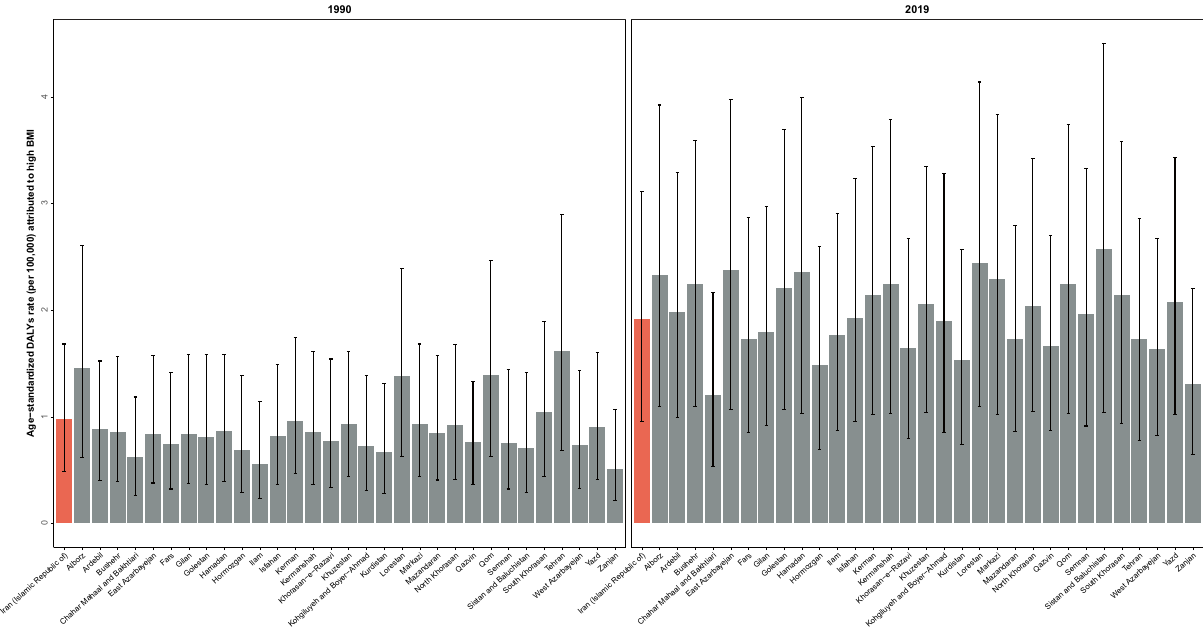
Figure 5. The thyroid cancer age-standardized DALYs attributed to high BMI in 1990 and 2019 in both sexes in provinces of ranged from 12% (− 27 to 67) to 92% (− 11 to 191). However, the ASDR decreased in four provinces from − 0.2 (− 31.9 to 42.1) in Chahar Mahaal and Bakhtiari to − 32% (− 52 to − 6) in Tehran (Supplementary Table 1 and Supplementary Fig. 1). In 1990, females had higher ASDR than males in all provinces, whereas in 2019, males had higher ASDR in five provinces. However, the significance of these differences has to be further evaluated in most of the provinces. However, in 2019, all provinces had lower female to male ratio compared to 1990. Fur- thermore, the highest and lowest female to male ratio in 1990 was 2.75 and 1.34, and in 2019, it was 2.05 and 0.80 respectively (Supplementary Table 1). Moreover, the age-standardized Mortality to Incidence Ratio (MIR) was higher in males in all of the provinces from 1990 to 2019 (Supplementary Fig. 2). Thyroid cancer DALYs. In the case of thyroid cancer DALYs among provinces of Iran, disparities were observ- able. Indeed, in 2019, it varied from 9.17 (7.62–10.92) in Zanjan to 21.30 (10.37–26.61) in Sistan and Baluchistan (Supplementary Table 1). Although, the age-standardized DALY rate increased in almost all provinces from 1990 to 2019, the difference between the province with the highest and the lowest rank was lower in 1990 (i.e. 9.69 versus 12.13). The age-standardized DALY rate was only decreased in Tehran [− 28% (95% UI: − 47 to − 2)]. Among the rest of provinces, the extent of change varied among provinces from 3% (− 28 to 54) to 122% (− 4 to 252) (Supplementary Table 1, and Supplementary Fig. 1). In 1990, females had higher age-standardized DALYs than males in all provinces. However, in 2019, in five provinces males had higher age-standardized DALYs. Simi- lar to previous indices, the significance of the differences between females and males are discussable. In 2019, all provinces had lower female to male ratio compared to 1990. Moreover, the highest and the lowest female to male ratio in 1990 was 2.61 and 1.26, whereas in 2019, it was 2.10 and 0.78 respectively (Supplementary Table 1). Thyroid cancer risk attributable DALYs. The high BMI is the only risk factor attributable to thyroid cancer introduced by the GBD studies. Here, the risk-attributable burden at national level will be reported at the Table 2, and the risk attributed burden at province level are presented in Supplementary Table 4. The risk attributable DALY in 2019 varied from 1.21 (0.53–2.16) in Chahar Mahaal and Bakhtiari to 2.58 (1.04–4.50) in Sistan and Baluchistan (Fig. 5). The risk attributable DALY increased in all of the provinces from 1990 to 2019. However, the difference between the first and the last rank was lower in 1990 (i.e. 1.11 versus 1.37). Besides, the extent of change in this index ranged from 7% (− 24 to 57) to 262% (53–536). In 1990, females had higher risk attributable DALYs than males in all provinces, whereas in 2019, males had higher risk attributable DALYs in half of the provinces. However, the uncertainty intervals overlapped in all of the provinces in both years. In 2019, all provinces had lower female to male ratio compared to 1990. In addition, the highest and lowest female to male ratio in 1990 was 2.64 and 1.29, and in 2019, it was 1.61 and 0.62 respectively. Thyroid cancer in SDI levels of Iran. The overall age-standardized rate of incidence, prevalence, deaths, and DALYs of thyroid cancer increased from 1990 to 2019 in almost all provinces in Iran from all five SDI levels (Fig. 6). However, in 2019, similar ASIRs, ASPRs, ASDRs, and DALYs were observed in provinces with different SDI levels. For example, in 2019, Isfahan [3.93 (2.32–5.03)] as a high SDI province and Sistan and Baluchistan [3.9 (1.92–4.99)] as a low SDI province were close together in case of ASIR of thyroid cancer. In contrast, East